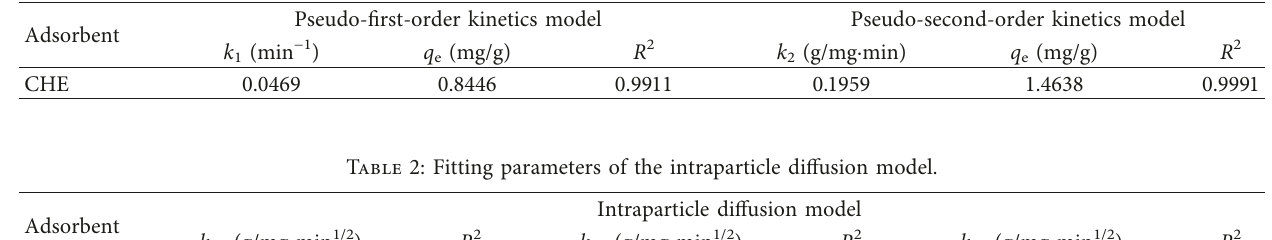
Figure 7: Fitting curves of various kinetics equations. Table 1: Parameters of the pseudo-first-order and pseudo-second-order kinetics models.